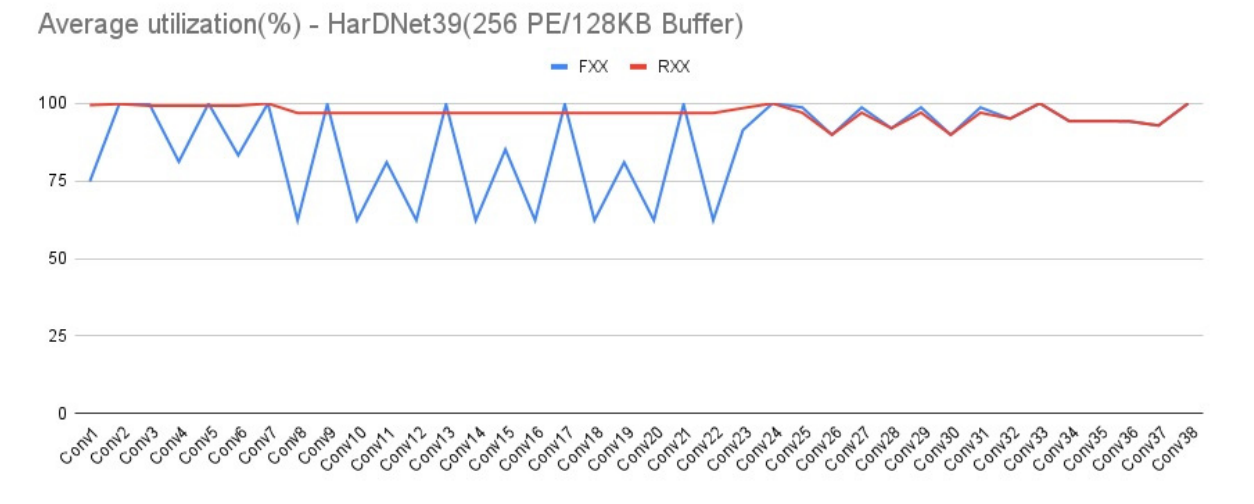
Figure 19. Average PE utilization—HarDNet39 (256 PE/128 KB Buffer).